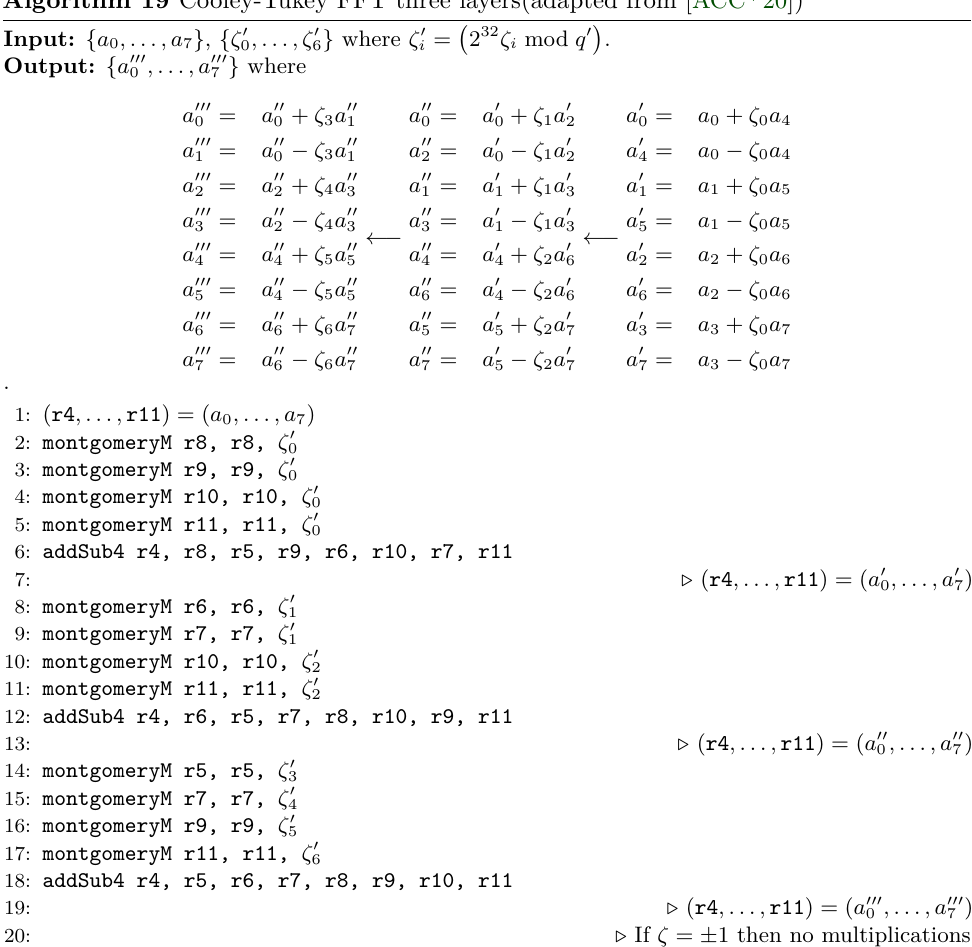
Algorithm 19 Cooley-Tukey FFT three layers(adapted from [ACC +